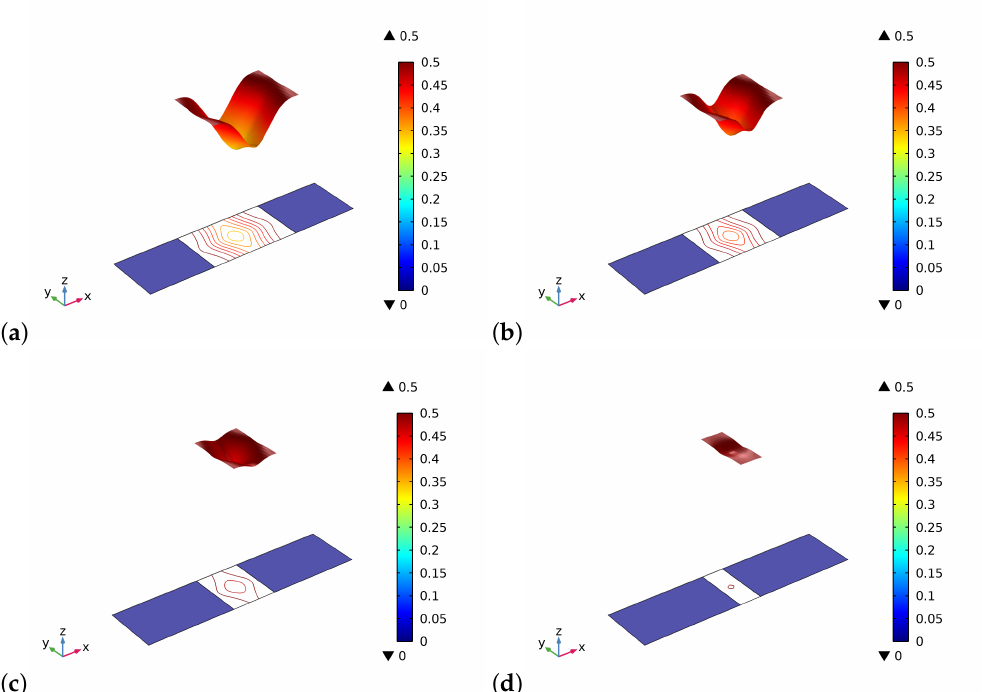
Figure 2. Plots of volume fraction of the bone tissue ρ ∗ different substitute lengths of the graft: ( a ) 0.8 cm. ( b ) 0.6 cm. ( c ) 0.4 cm. ( d ) 0.2 cm.